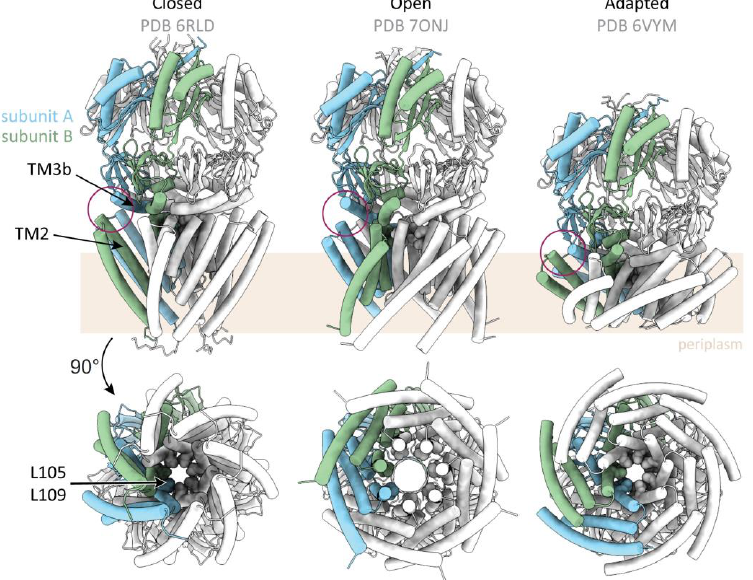
Figure 3. Structures of distinct functional states of MscS. Three different conformational states of MscS were observed so far on a structural level: the closed state (left; PDB 6RLD [19]), a conducting state (middle; PDB 7ONJ [21]), and an adapted one (right; PDB 6VYM [22]). The three structures are shown in the same orientation, with one subunit depicted in green and one in blue, either viewed from the side ( top ) or along the pore axis from the periplasmic side ( bottom ) The membrane is indicated by the pale brown rectangle. The hydrophobic sealing ring of the pore, which is comprised of the two Leucine residues L105 and L109, is shown in ball representation. Upon opening, the sensor paddles increase their tilt in the plane of the membrane and the pore helix TM3a shifts outwards ( middle ). Additionally, the latter rotates around its own helical axis, which withdraws the locking leucine residues from the pore axis, resulting in a conducting state. The sensor paddles of the presented adapted state ( right ) are tilted even more within the membrane plan, which leads to a flattened TMD, while the pore is occluded by the sealing residues. Concluding from the existing structures, it was proposed that the state of the pore is related to the alignment of the helices TM2 and TM3b (pink circle): If there is an interaction between helices from different subunits, the channel is non-conducting, as observed in the closed and adapted conformation. If the interaction takes place between the helices TM2 and TM3b of the same subunit, the pore is in a conducting state.